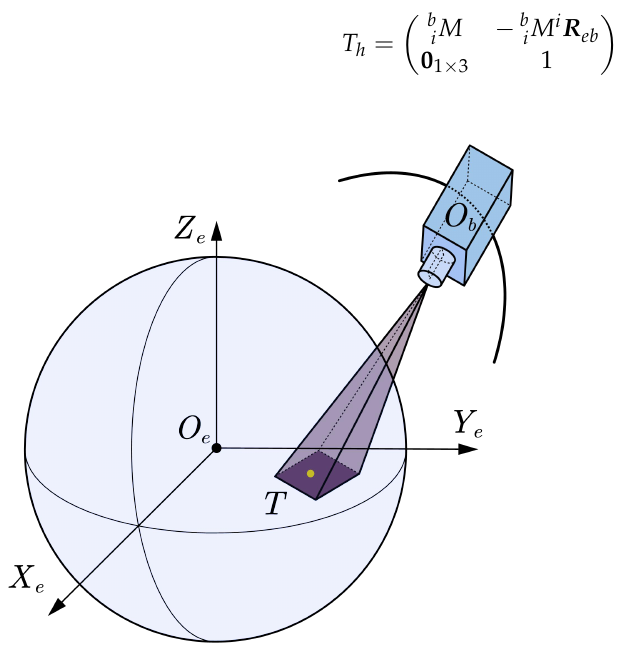
Figure 3. Staring observation for a single ground